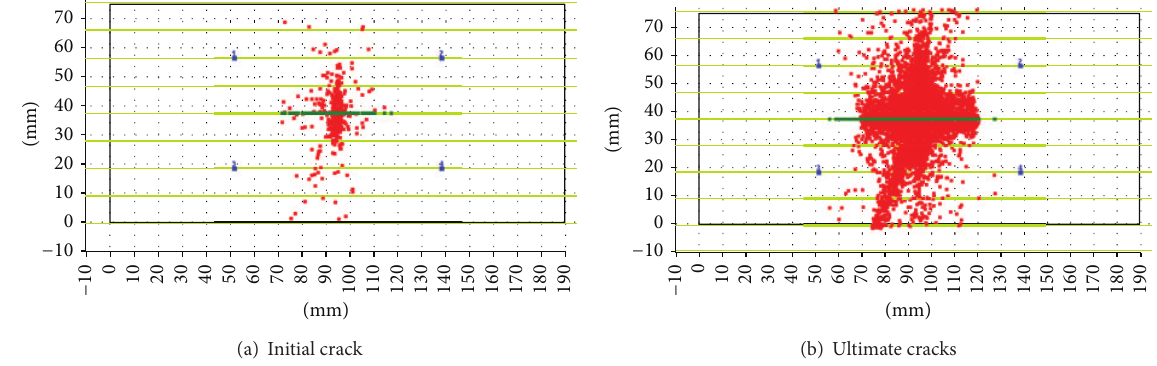
Figure 5: AE location of rock plate under concentrated